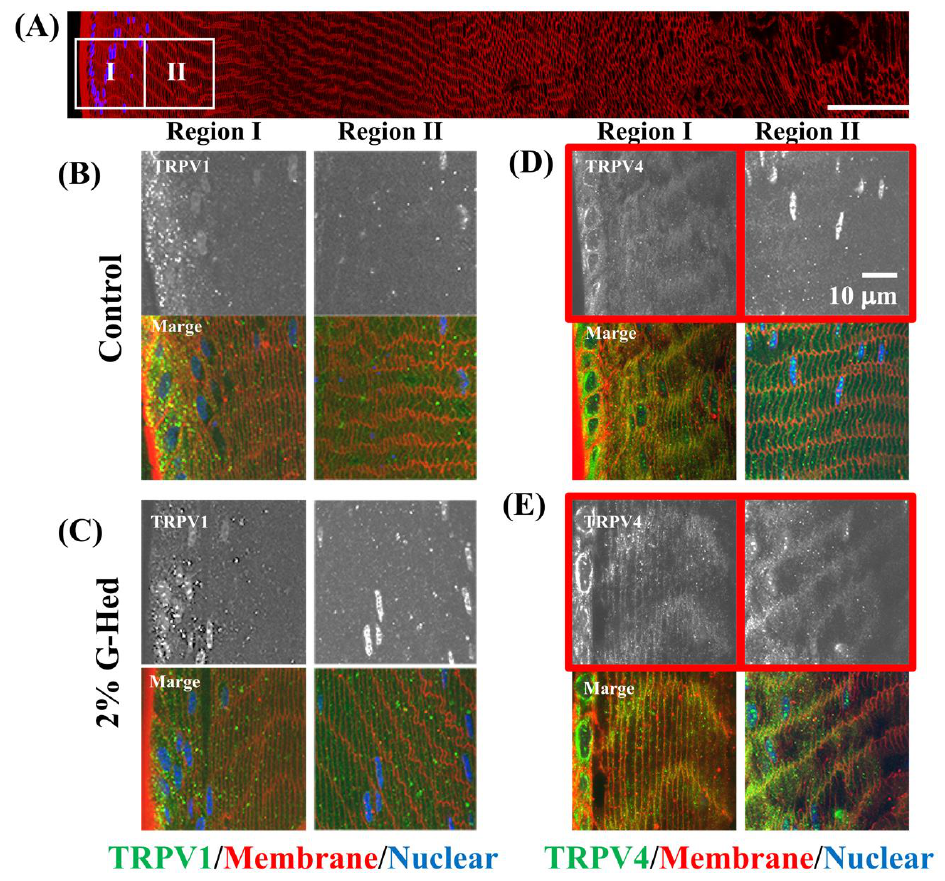
Figure 5. Effect for distribution of TRPV channels in the peripheral region of the lens. After LT treatment of G-Hsd, subcellular localization of TRPV1 and TRPV4 in the peripheral regions of the lens was measured using confocal microscopy. ( A ) A montage of images collected from the lens equator to the core. High power images from the outer 2 regions (boxes) were obtained. ( B , C ) High magnified images of sections labeled with TRPV1 from ( B ) control mice lens and ( C ) 2% G-Hsd for 49-week exposed mice lens. Upper panels are images of TRPV1 signal alone, and lower panels were merged images with TRPV1, WGA, and DAPI. ( D , E ) High magnified images of sections labelled with TRVP4 from ( D ) control mice lens and ( E ) 2% G-Hsd for 49-week exposed mice lens. Upper panels were images of TRPV4 signal alone, and lower panels were merged images of TRPV4, WGA, and DAPI. The experiments used three to five independent samples per group.